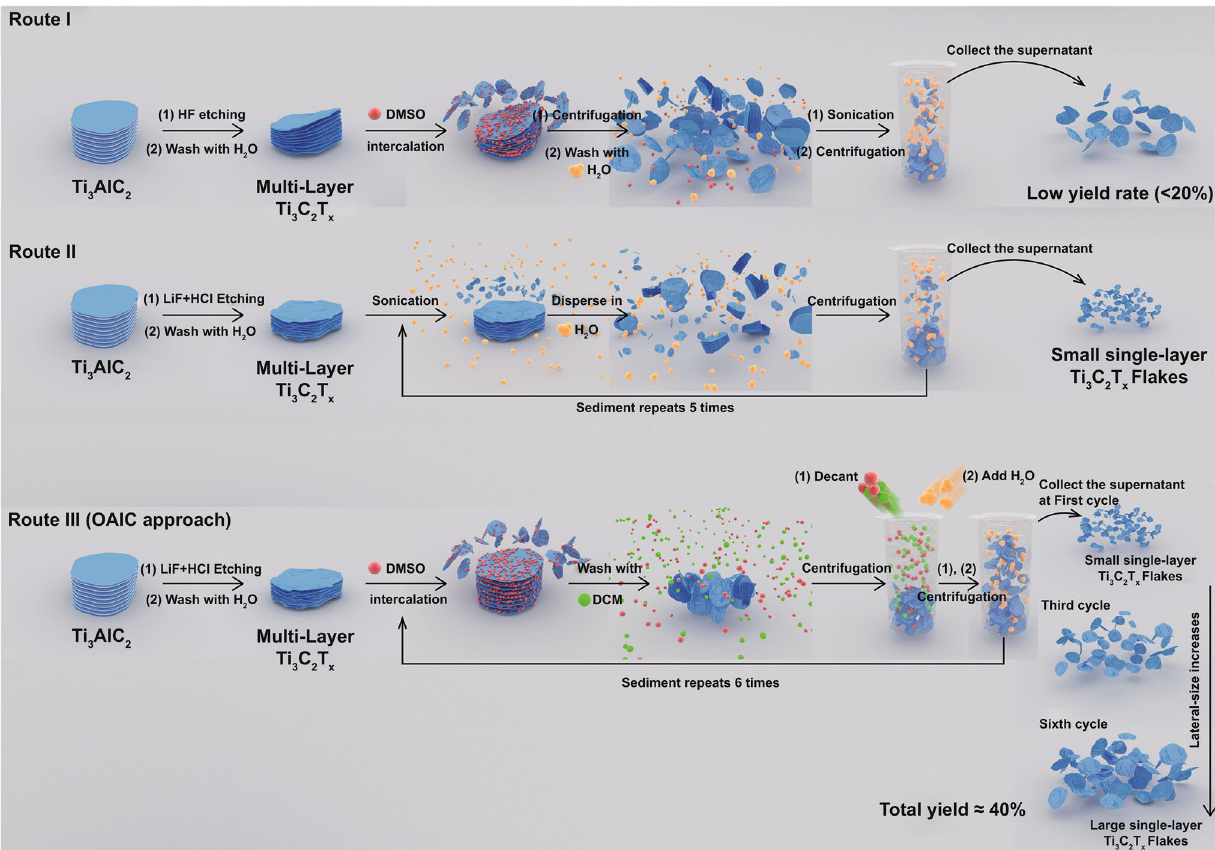
Fig. 1 Schematic flow process for preparing Ti 3 C 2 T x flakes by Route I (HF etching followed by DMSO intercalation), Route II (LiF/HCl etch- ing, followed by sonication) and Route III (organic solvent-assisted intercalation and collection